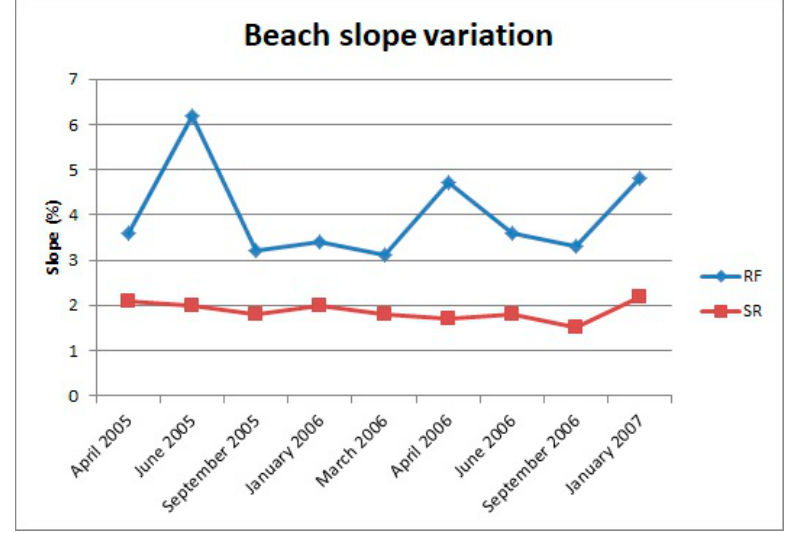
Figure 4. Slope (%) of the two kinds of beaches (reef flat, RF, is blue and sand-rich, SR, is red) during the April 2005–January 2007 period.